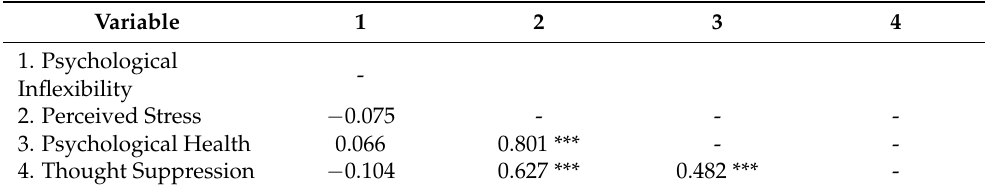
Table 3. Correlations matrix: 6-PAQ, PSS, GHQ and WBSI for group 1 (low PI, n = 58).